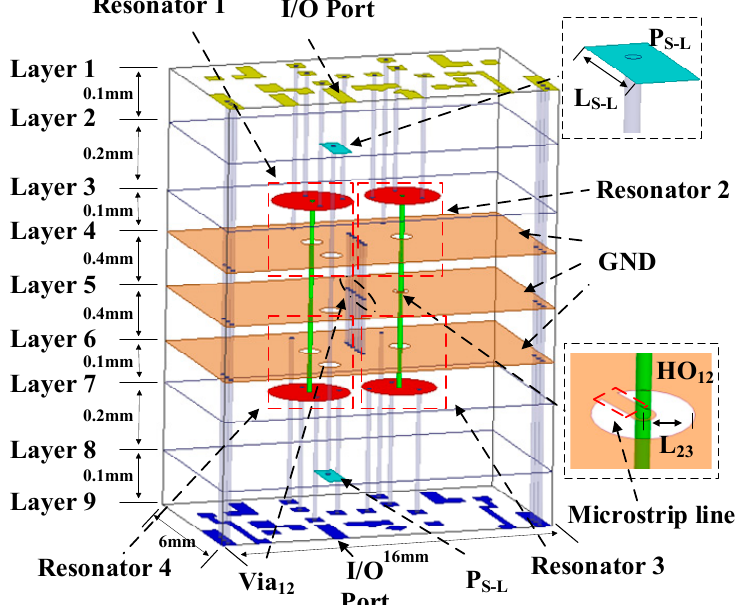
Figure 1. The 3-dimensional structure of the proposed LTCC filter.